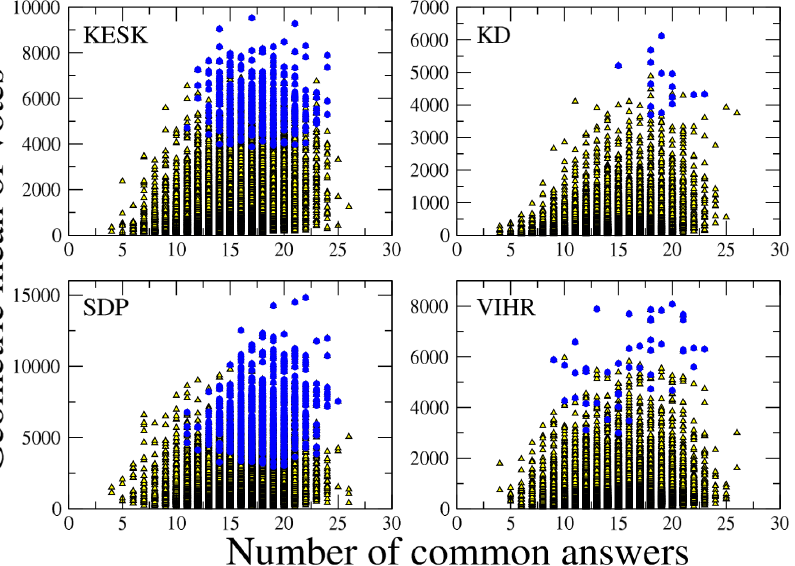
Figure 2. Scatter plot of votes VS number of common answers within each of four parties. Scatter plot of the geometric mean of the votes obtained versus the number of common answers for each pair of candidates belonging to the four parties KESK (top left), KD (top right), SDP (bottom left) and VIHR (bottom right). Yellow triangles denote pairs of non elected candidates, whereas blue circles denote pairs of candidates that have been elected.